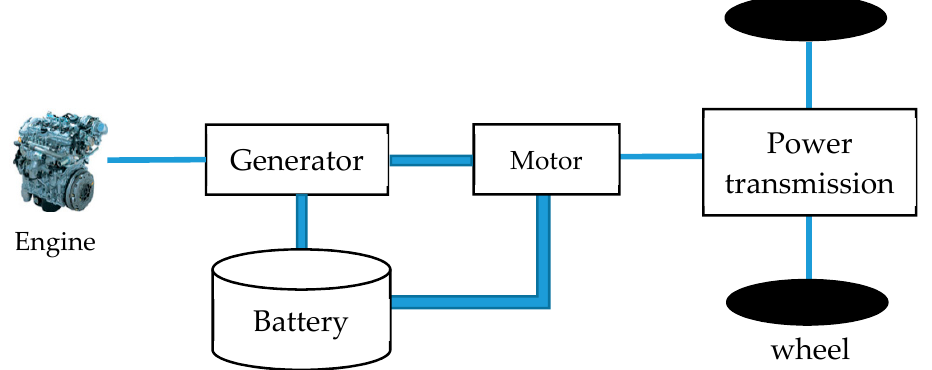
Figure 1. System structure of extended-range electric vehicle (E-REV).